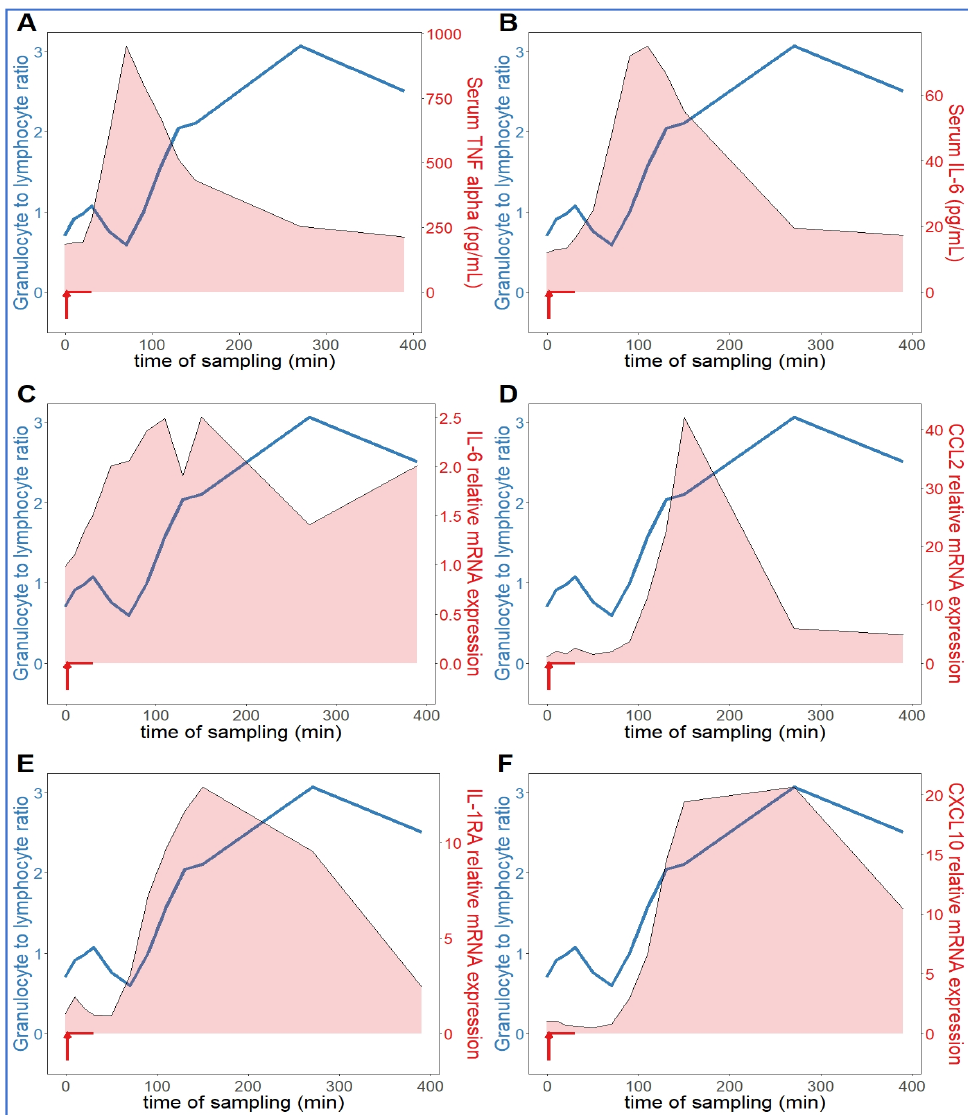
Figure 6. Relationship between serum cytokine levels and NLR. The NLR (neutrophil granulocyte-to-lymphocyte ratio (blue line) increased continuously in an hour after zymosan administration, which was preceded by increased TNF-alpha ( A ) and IL-6 ( B , C ). The expression of CCL2 ( D ), IL-1RA ( E ) and CXCL10 (IP-10, ( F )) genes proceeded in parallel with the rise in NLR ( n = 9).